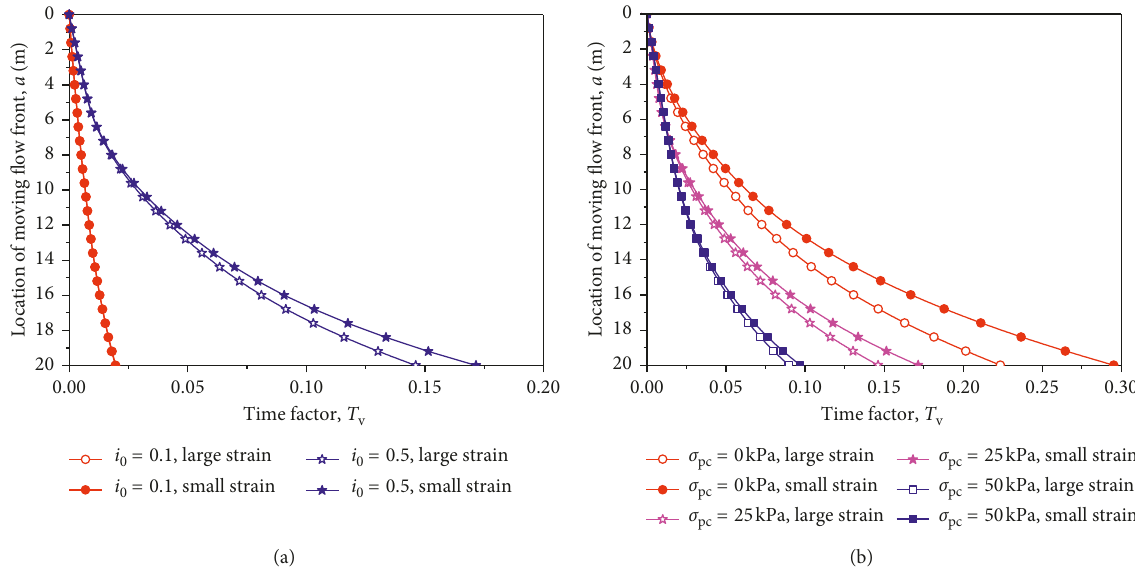
Figure 7: Influences of geometric suppositions on the moving rate of the flow front: (a) under different threshold hydraulic gradient i under different preconsolidation pressure σ pc